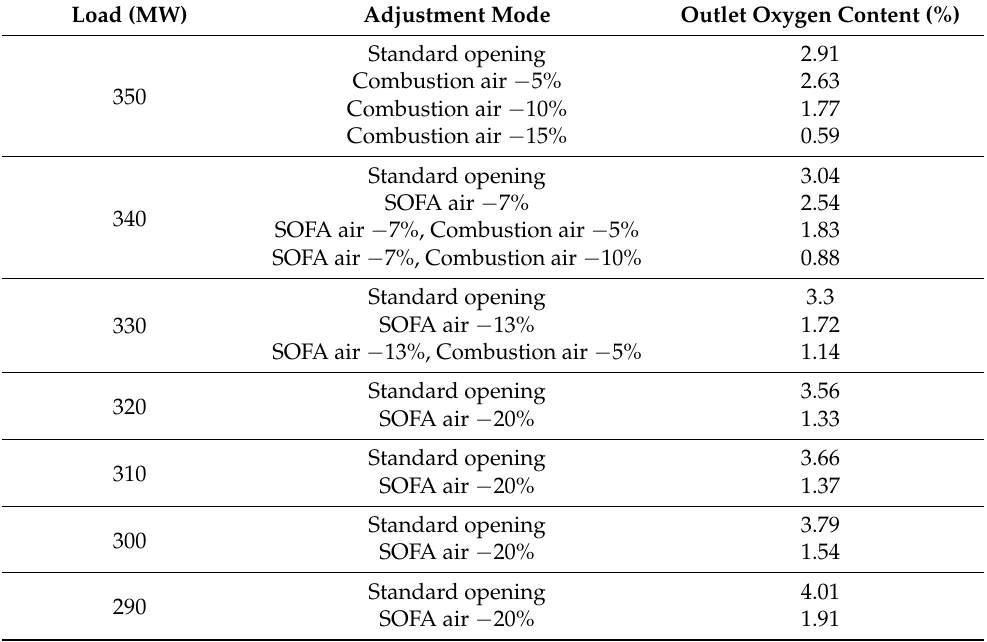
Table 11. 290–350 MW influence of different air distribution modes on the outlet